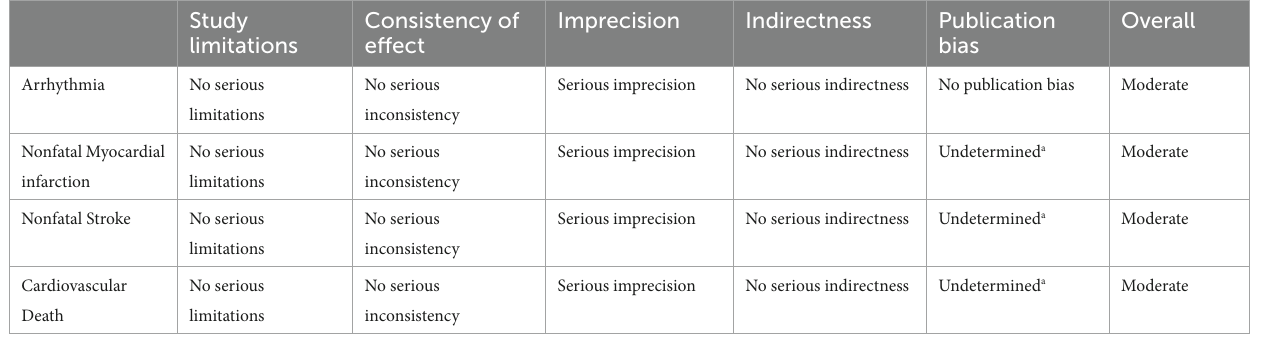
TABLE 6 SOE domain scores according to the GRADE